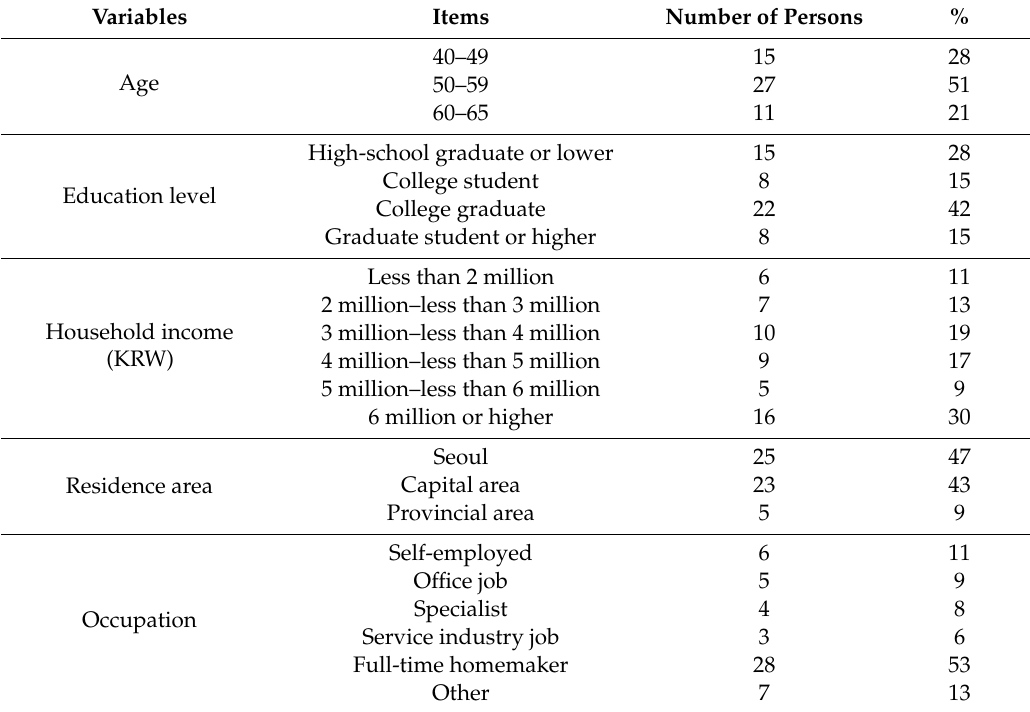
Table 4. General characteristics of